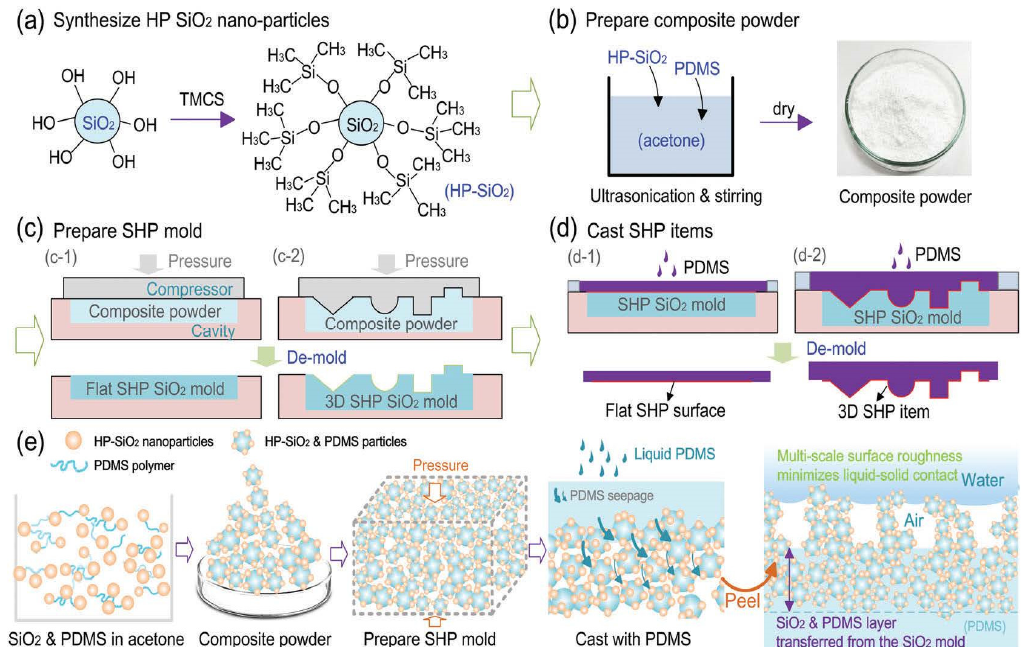
Figure 4. The processes of sand-casting superhydrophobic items by Zhe Li, Ba Loc Nguyen, and others [75]. ( a ) Synthesis of hydrophobic-SiO 2 nanoparticles; ( b ) preparation of hydrophobic-SiO 2 and PDMS composite powder; ( c ) preparation of the superhydrophobic SiO 2 mold; ( d ) casting of superhydrophobic items using the mold; ( e ) illustration of the sand-casting processes, showing particle aggregation and transfer of SiO nanoparticles from the SiO mold to the final casted item. Researchers have also investigated insoluble salts, such as calcium phosphate, for possible coating materials [76]. Calcium phosphate-containing coatings are preferred for